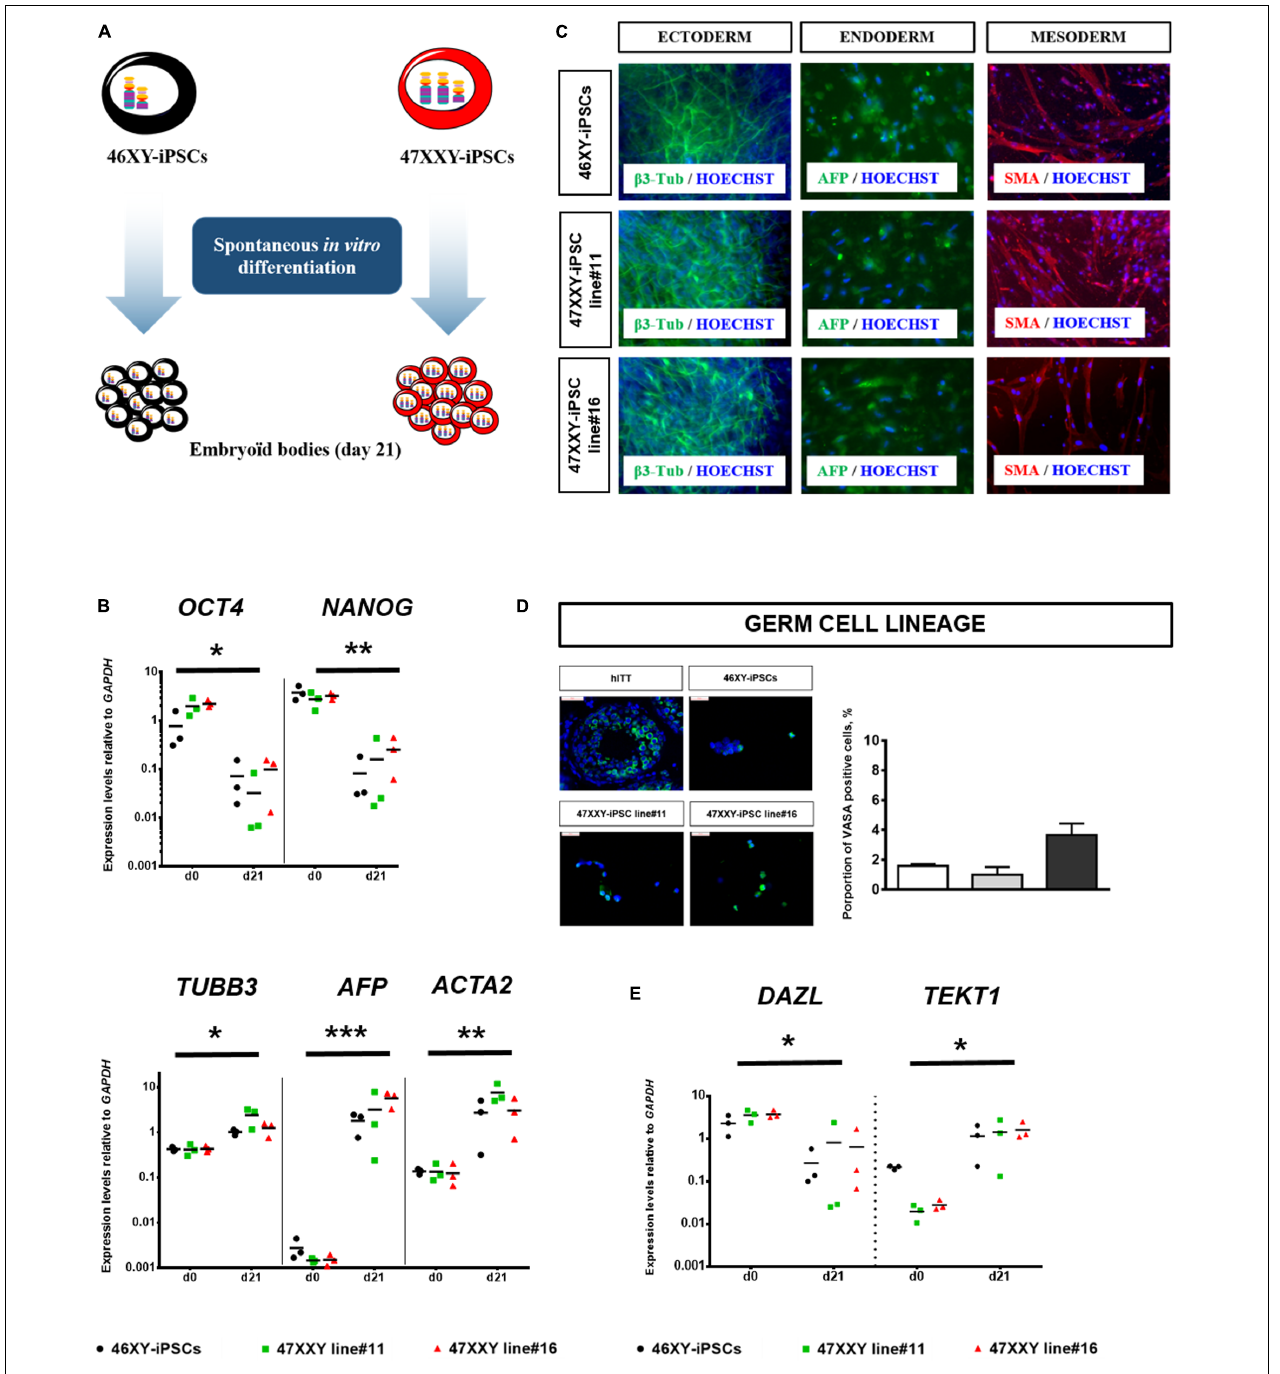
FIGURE 2 | Spontaneous in vitro differentiation of 46XX-iPSCs and 47XXY-iPSCs. (A) Schematic representation for spontaneous in vitro differentiation of 46XY-iPSCs and 47XXY-iPSCs into the three embryonic germ layers as embryoïd bodies (EBs) in suspension culture for 4 days and as adherent cells for an additional 17 days. (B) Quantitative RT-PCR of pluripotency-related genes ( NANOG and OCT4 ) and of markers for mesoderm ( ACTA2 ), endoderm ( AFP ), and ectoderm ( TUBB3 ). Expression levels are expressed relative to GAPDH . (C) Immunofluorescence staining of 46XY-iPSC and 47XXY-iPSC lines upon spontaneous in vitro differentiation, for markers of mesoderm ( α -SMA), endoderm (AFP) and ectoderm ( β 3-tubulin). (D) Immunofluorescence staining of 46XY-iPSC and 47XXY-iPSC lines upon spontaneous in vitro differentiation for the germ cell marker VASA. Quantitative analysis of the proportion of VASA positive cells after 21 days of spontaneous in vitro differentiation. Human immature testicular tissue (hITT) was used as a positive control (scale = 50 µ M). (E) Quantitative RT-PCR analysis of markers of germ cell development ( DAZL and TEKT1 ) upon spontaneous in vitro differentiation of 46XY-iPSC and 47XXY-iPSC lines. Expression levels are expressed relative to GAPDH . Data are represented as variance around mean, ∗ p < 0 . 05, ∗∗ p < 0 . 01 and ∗∗∗ p < 0 . 001 between day 0 and day 21 from n = 3 independent experiments.